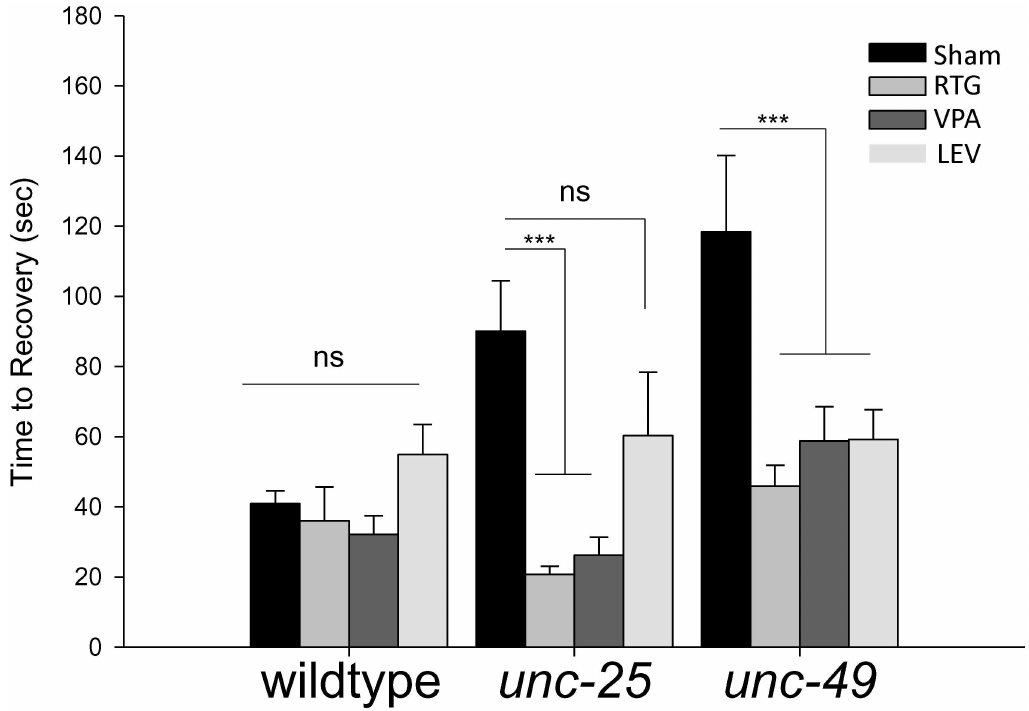
Fig 3. Electroshock recovery time is increased with loss of GABAergic transmission, and improved by antiepileptic drugs. In control conditions, wild-type C . elegans take significantly less time to recover from an electric shock when compared to loss-of-function mutations in the GABA biosynthetic enzyme unc-25 or the GABA receptor unc-49 . Treatments with 3.0 mM LEV, 1.0 mM RTG and 3.0 mM VPA reduce unc-25 and unc-49 mutant recovery. Error bars represent standard error of the mean and significance was determined using two-way ANOVA and Holm- Sidak multiple comparisons test where *** P (cid:20) 0.001. ns = not significant P>0.05 and n (cid:21) 17.